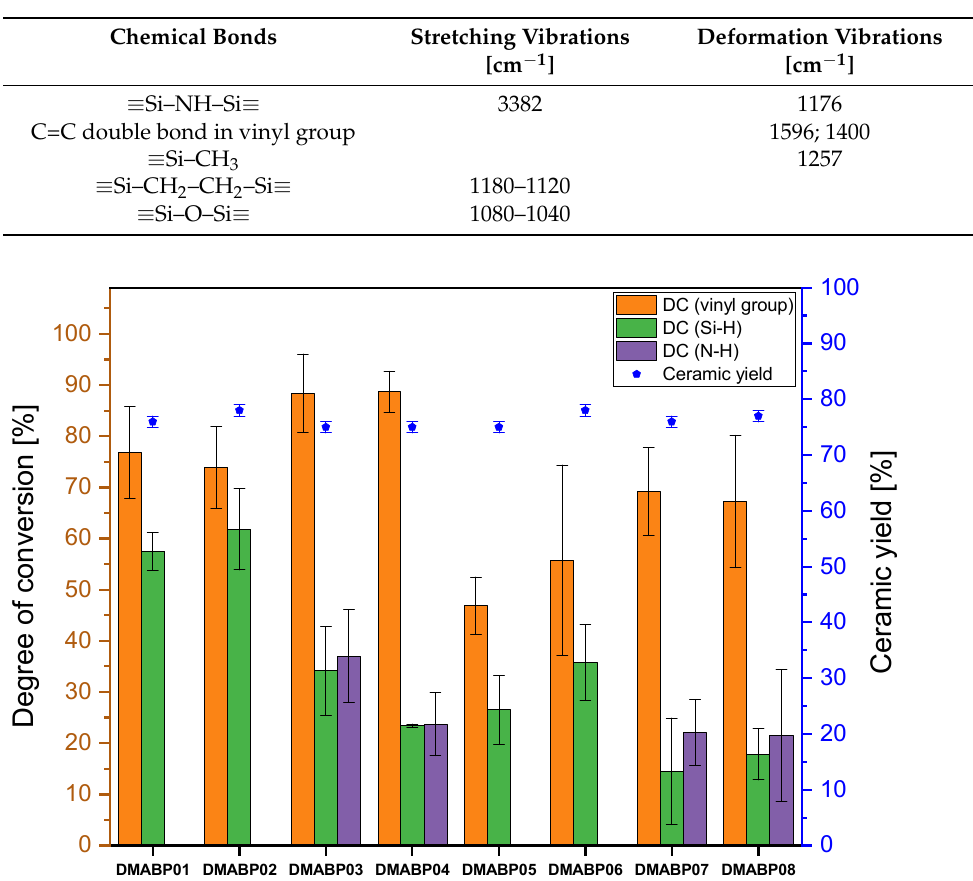
Table 3. Overview of important FTIR stretching and deformation vibrations in Durazane 1800 [38].